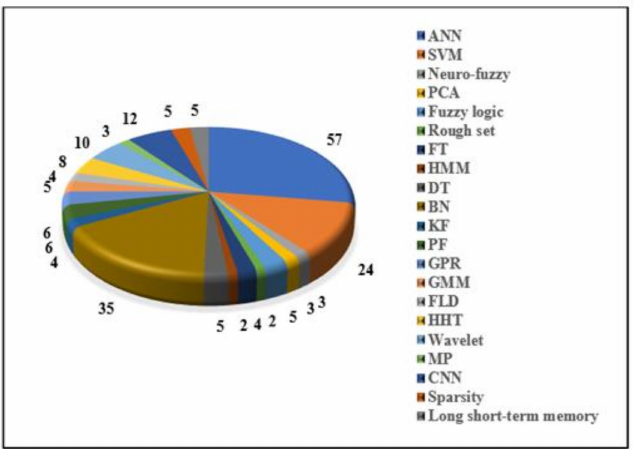
Figure 17. The frequency of algorithm application in studies. ANN—artificial neural network, SVM—support vector machine, PCA—principal component analysis, FT—Fourier transform, HMM— hidden Markov model, DT—decision trees, BN—Bayesian networks, KF—Kalman filter, PF—particle filter, GPR—Gaussian process regression, GMM—Gaussian mixture model, FLD—Fisher linear discriminant, HHT—Hilbert–Huang transform, MP—multilayer perceptron, CNN—convolutional neural network, LSTM—long short-term memory.